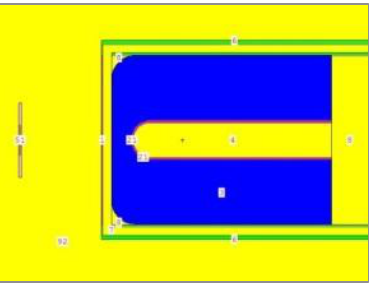
Figure 2: MCNPX simulation of the setup for activation measurement (target and HPGe detector).